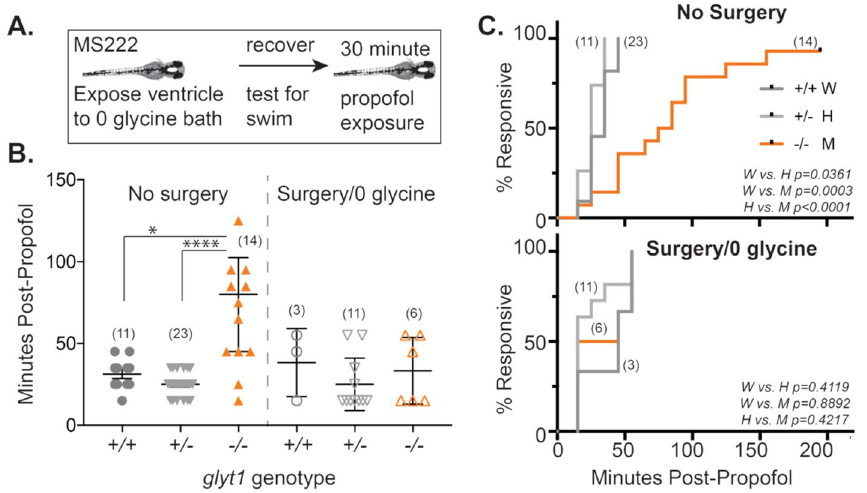
Figure 4. Reducing glycine accelerates emergence from propofol in glyt1−/− mutants. ( A ) To test the role of glycine in delayed emergence from anesthesia, we anesthetized five-day-old glyt1 sibling (+ /- light gray; + / + dark gray) and mutant ( − / − orange) larvae with tricaine, surgically exposed brain ventricles to a 0-glycine bath solution, tested larvae for intact swimming behavior and then anesthetized them with propofol for thirty minutes and measured their time to recovery. Numbers in each experimental group are indicated in parentheses on the plots in B and C. ( B ) Scatter plots of times to emergence post-propofol are plotted for larvae that were not surgically manipulated (left) and larvae with surgically exposed brain ventricles (right). Results were analyzed with a two-way ANOVA (treatment and genotype) followed by Wilcoxon/Kruskal Wallis test of significance. Asterisks indicate p -value: * p < 0.05, ** p < 0.001, *** p < 0.001, **** p < 0.0001. glyt1−/− mutants emerged significantly more slowly than wild type siblings and glyt1−/− mutants with surgically exposed brain ventricles. ( C ) Kaplan–Meier plots of the proportions of responsive fish against time-post-propofol for the same glyt1 + / + , glyt1 + /- , and glyt1−/− larvae presented in B are shown for No Surgery (top) and Surgery/0 glycine (bottom). p -values are calculated using log rank